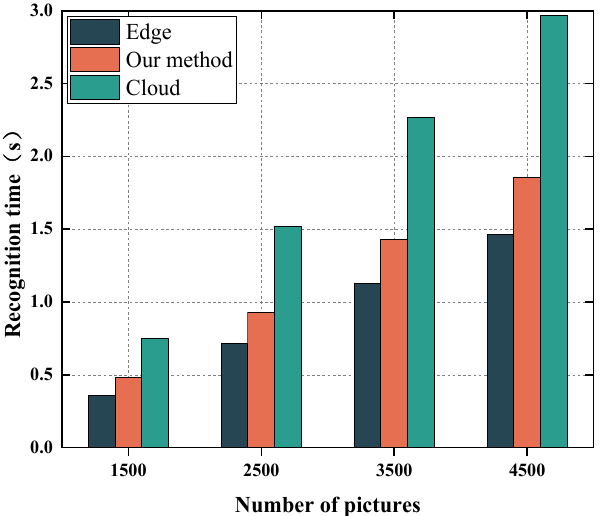
Figure 7. Recognition time for three different